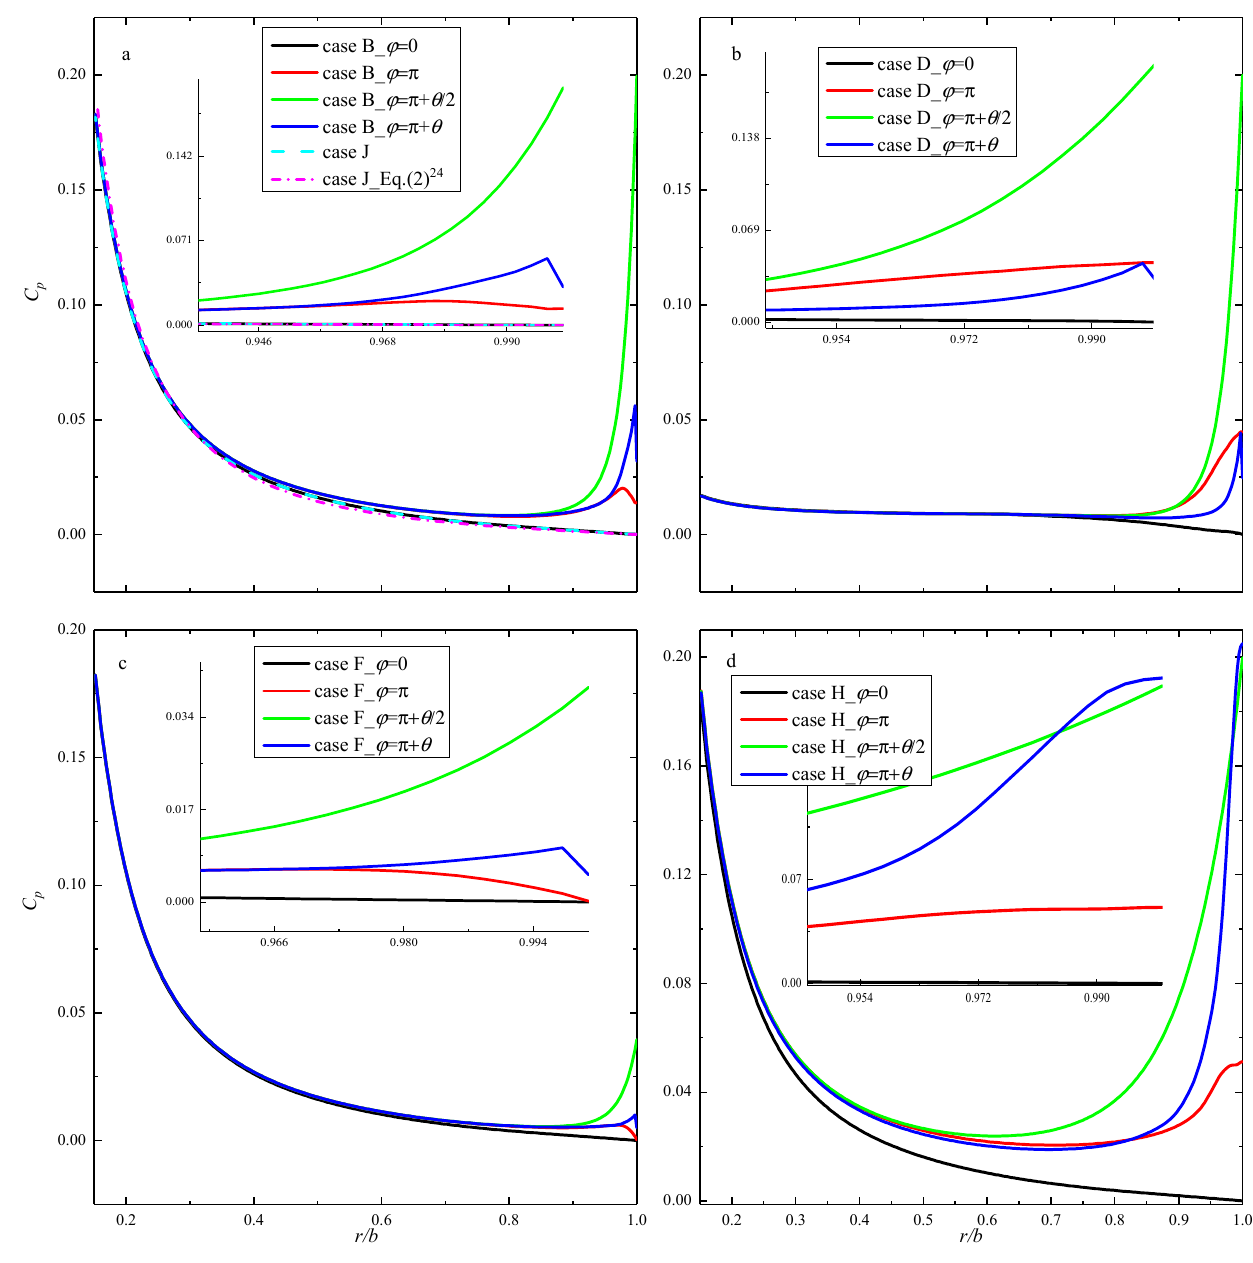
Figure 18. Pressure coefficient of different cases at plane z / s = 0.5: ( a ) case B, ( b ) case D, ( c ) case F, ( d ) case H.